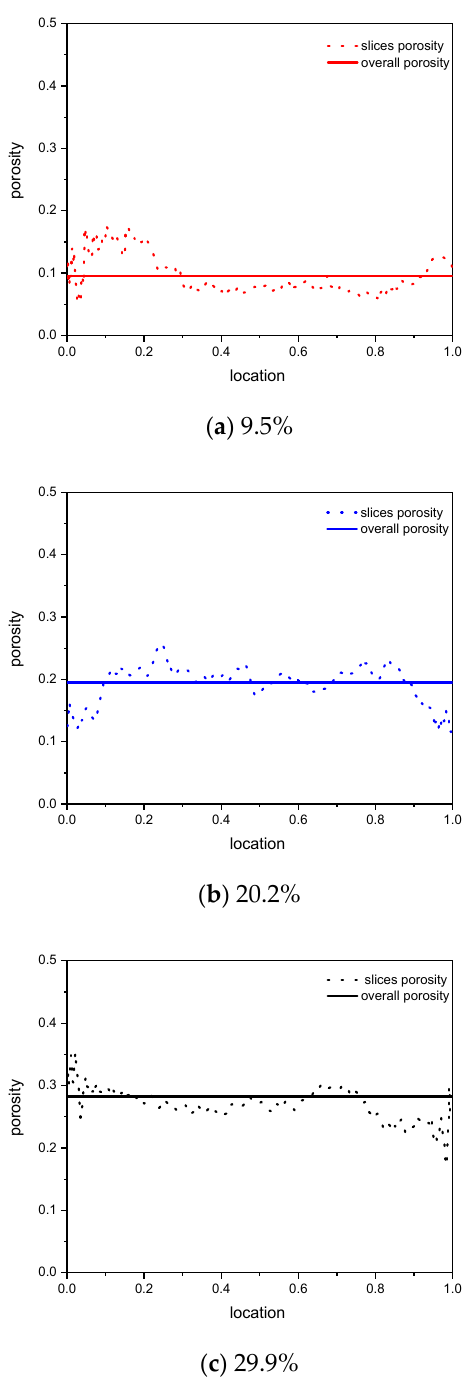
Figure 6. The pore distribution characteristics for porous AP nano-CT slices.